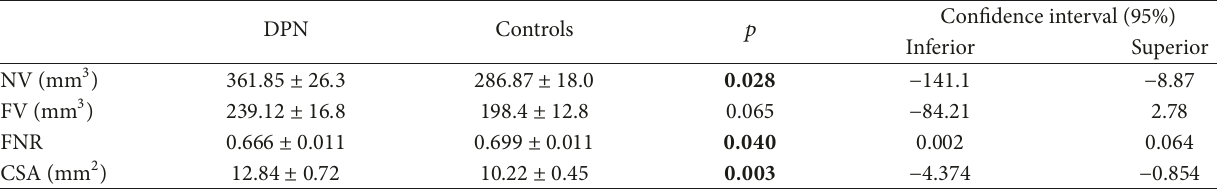
Table 2: Comparison of parameters between subjects with diabetic neuropathy and controls. Data is expressed in mean ± SEM. Bold characters are used to enhance statistical significance. DPN = diabetic peripheral neuropathy. NV = mean of the nerve volumes (for a length of 28 mm). FV = mean of the fascicles volumes (for a length of 28mm). FNR = fascicles to nerve ratio. CSA = mean of the cross-sectional areas. There is statistical difference ( 𝑝 < 0,05) in NV, FNR, and CSA between subjects with diabetic neuropathy and controls.